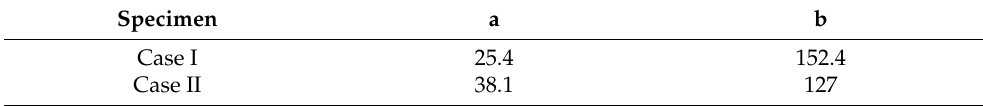
Table 2. Configurations of the PMMA